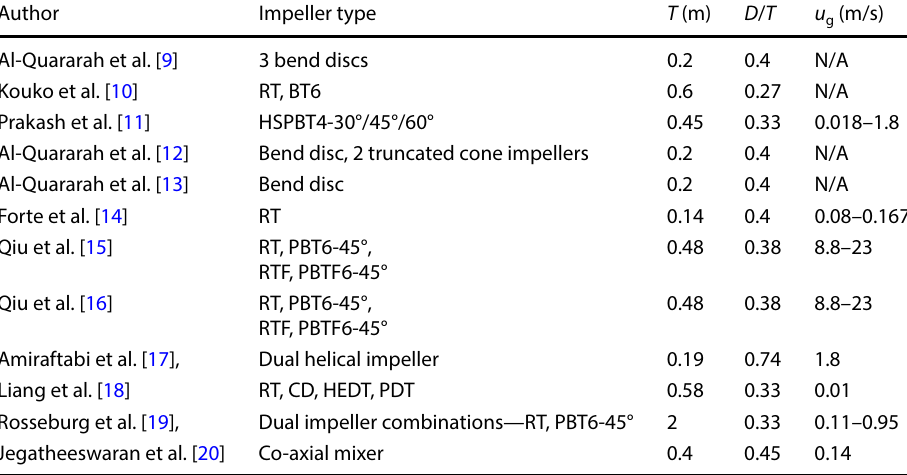
Table 1 Recent experimental studies on gas dispersion in mixing tanks